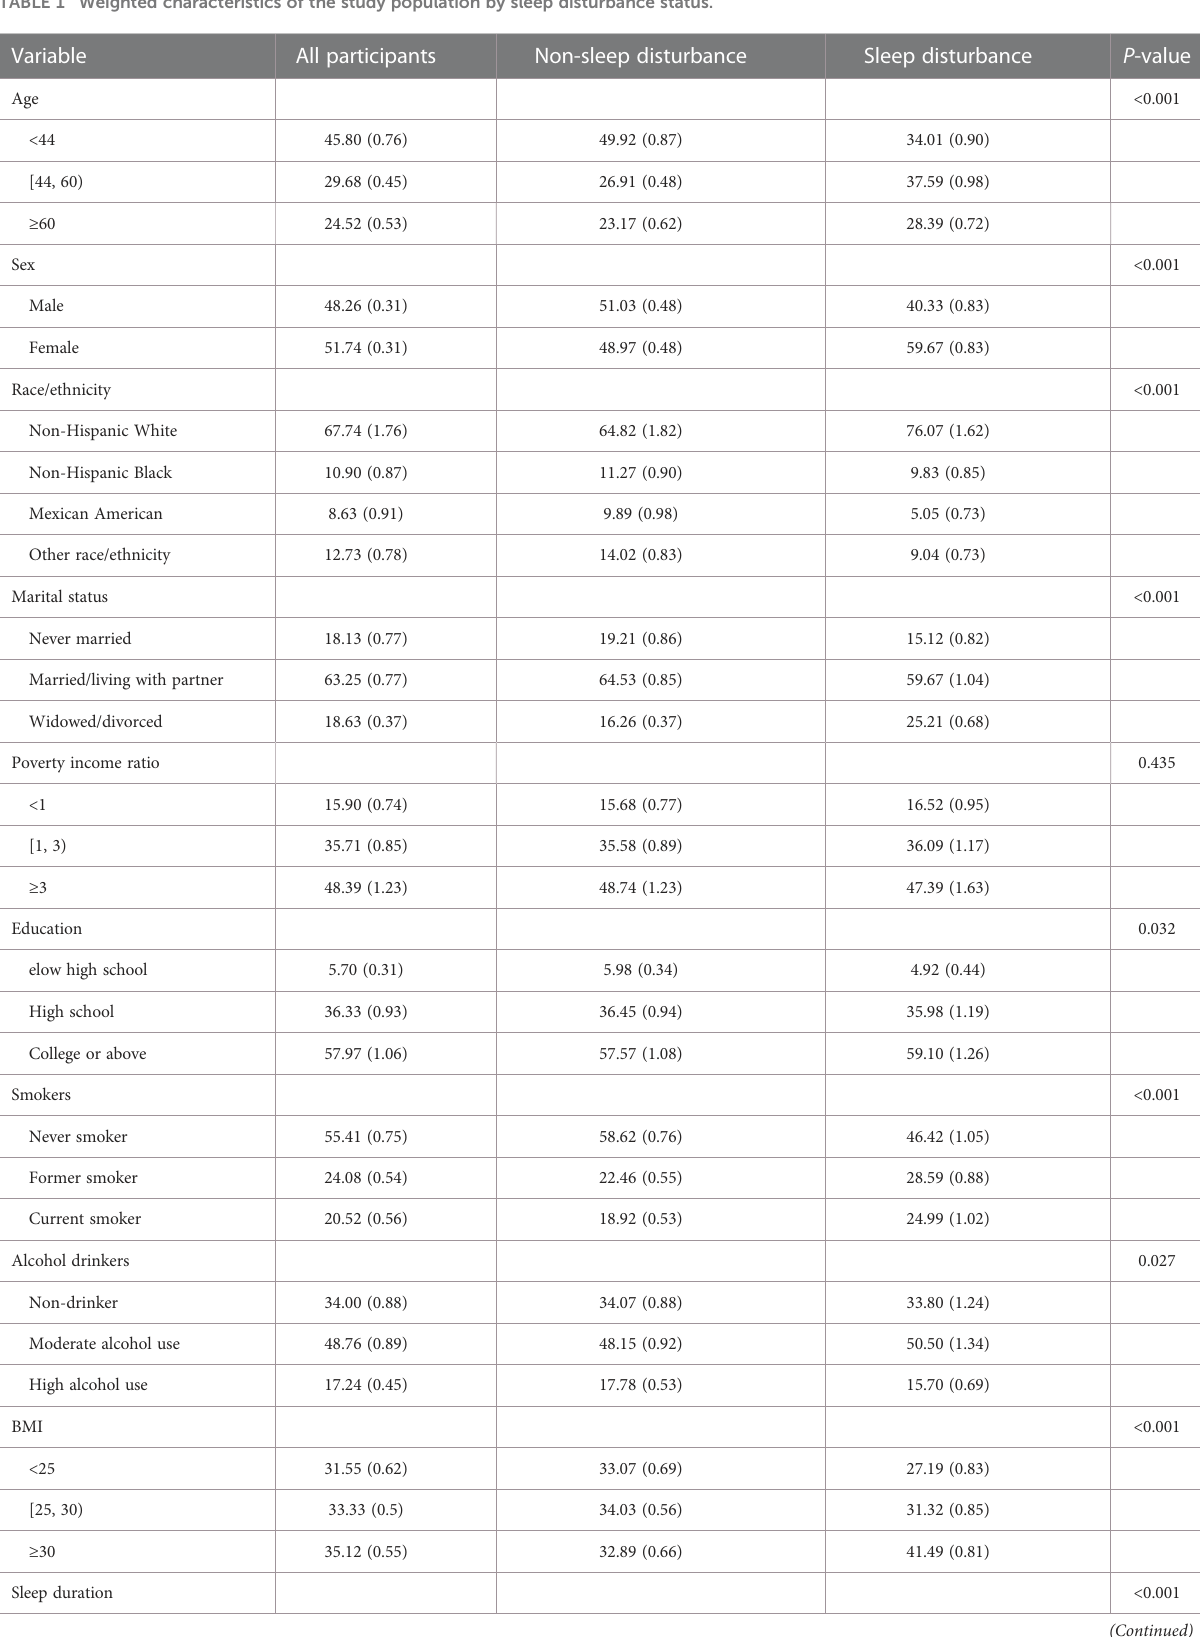
TABLE 1 Weighted characteristics of the study population by sleep disturbance